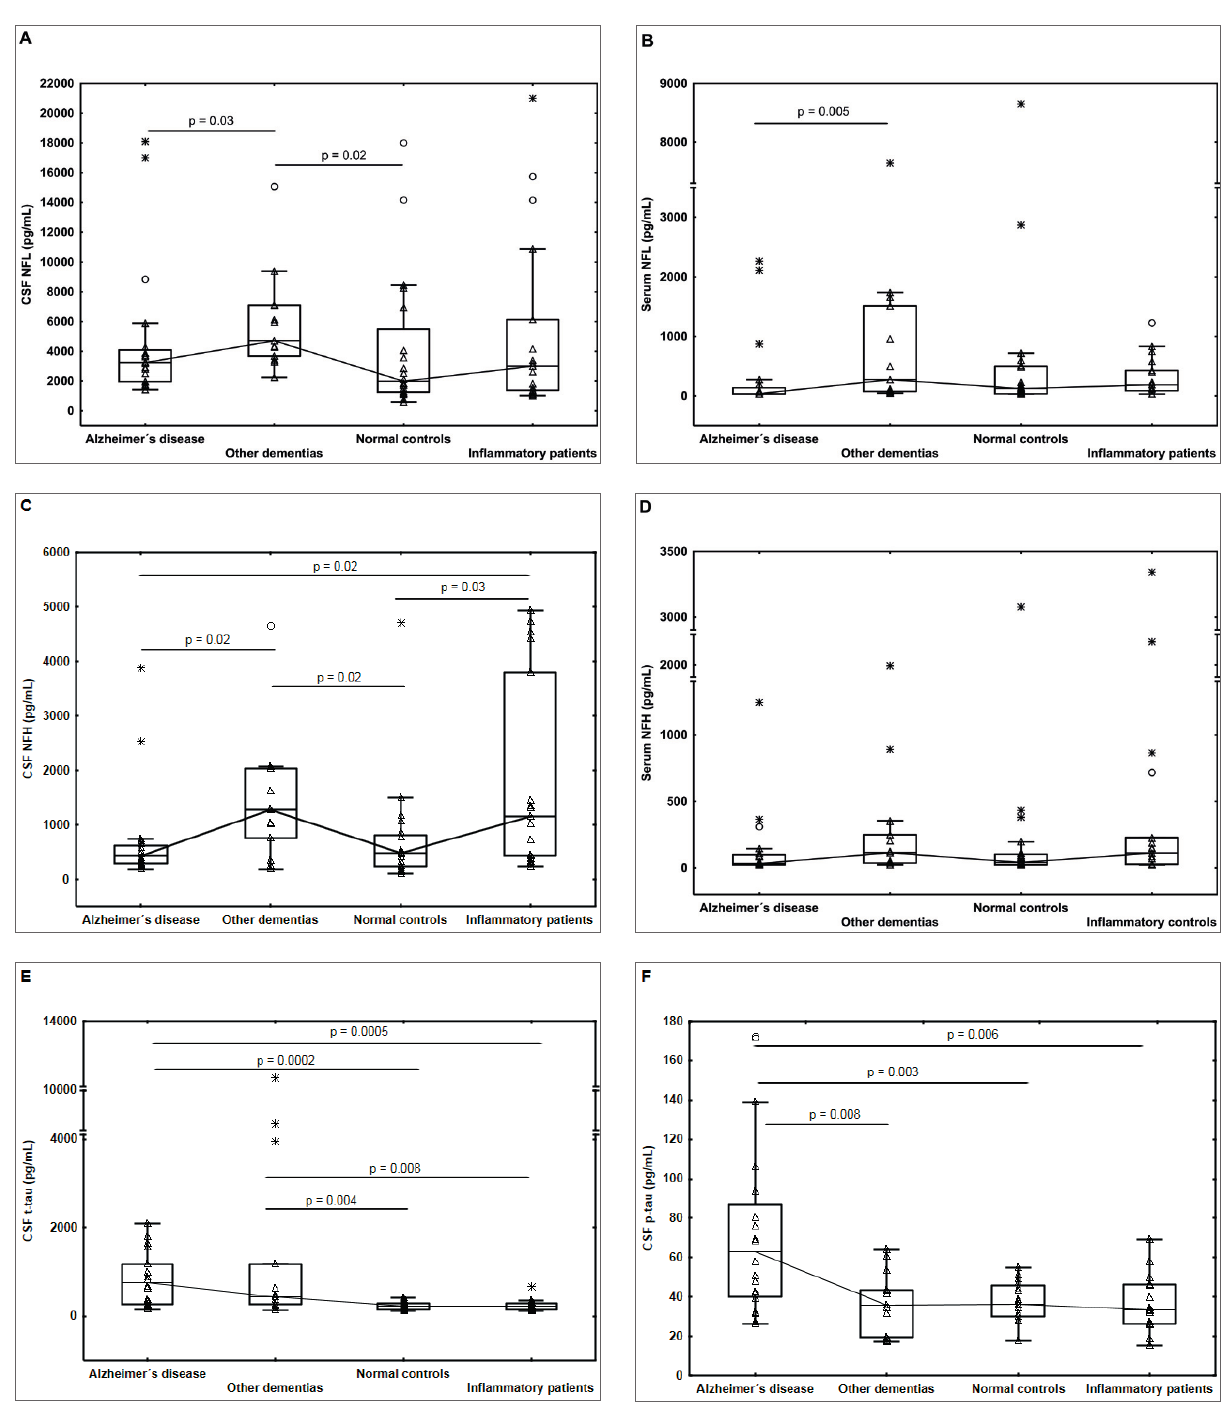
Fig. 1. Comparisons of levels among patients’ groups (A) in neurofilament light subunits in cerebrospinal fluid; (B) in neurofilament light subunits in serum; (C) in neurofilament heavy subunits in cerebrospinal fluid; (D) in neurofila- ment heavy subunits in serum; (E) in total tau in cerebrospinal fluid; (F) in phosphorylated tau in cerebrospinal fluid. The box plots include the median (horizontal line ─), values from the 25 th to the 75 th percentiles (boxes); bars (whiskers) above and below the box indicate the range of non-outliers. Non-outliers are indicated by triangles. Outliers and extremes are shown by circles and asterisks (the outlier values are outside the 1.5 box length from the upper and lower value of the box; the extreme values are outside the 3 box length from the upper and lower value of the box). CSF - cerebrospinal fluid; NFH - neurofilament heavy subunits; NFL – neurofilament light subunits; p-tau - phosphorylated tau; t-tau - total